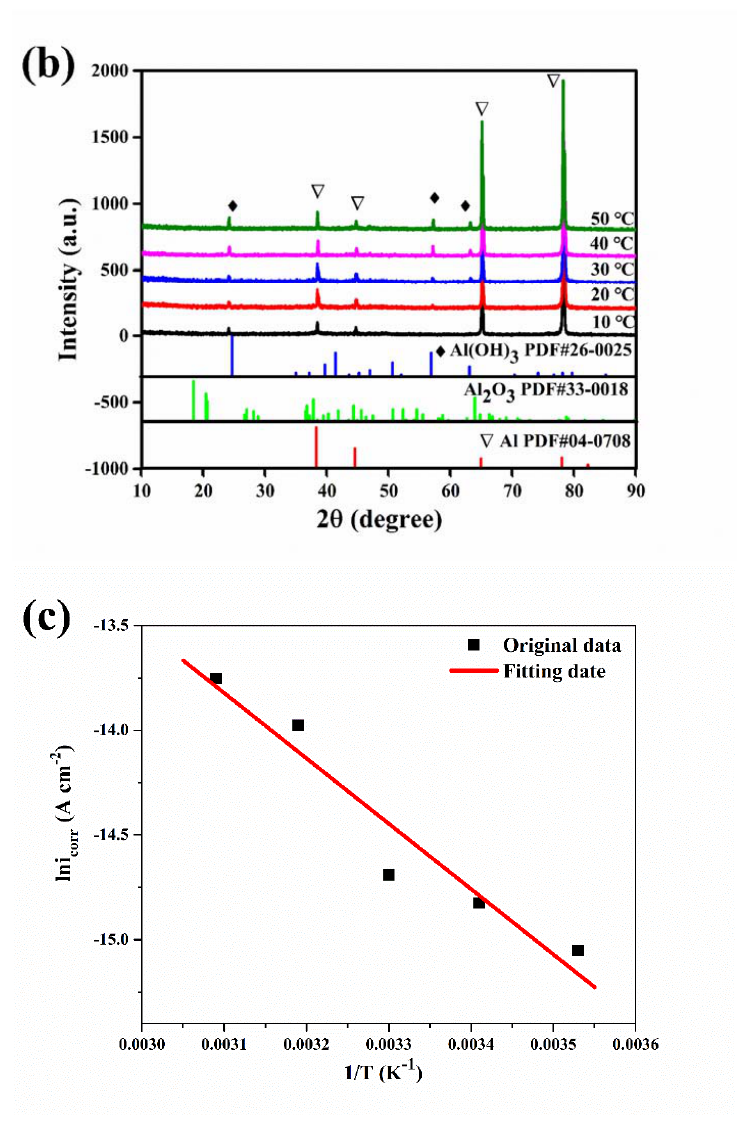
Figure 6. IR spectrum ( a ) of the aluminum electrode after a constant voltage corrosion of 0.5 V for 0.5 h in 50 °C deionized water, XRD spectra ( b ) of the aluminum electrode after a constant voltage corrosion of 0.5 V for 0.5 h at various temperatures and the Arrhenius linear fitting curves ( c ) of aluminum at various temperatures .